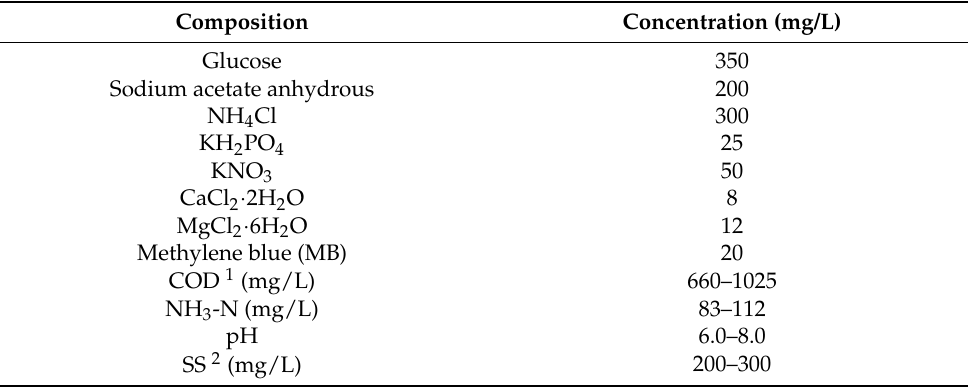
Table 1. Synthetic textile wastewater